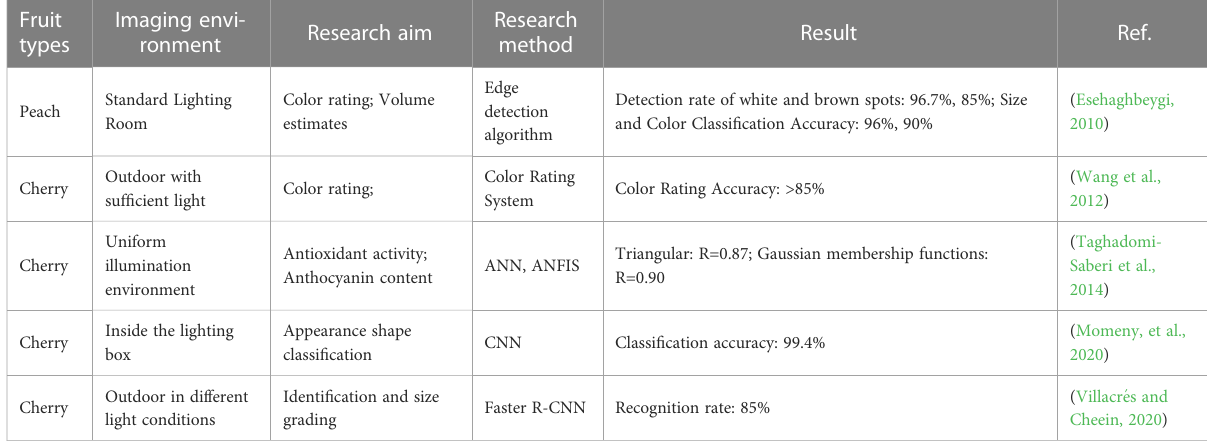
TABLE 3 Research summary of fruit quality detection based on phenotypic information using RGB images. Fruit